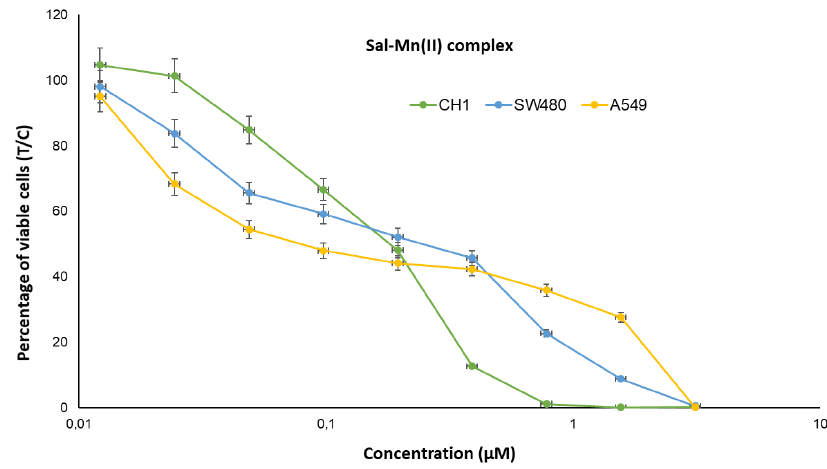
Figure 6. Concentration-effect curves of the Sal-Mn(II) complex in A549 (yellow), CH1/PA-1 (green), and SW480 (blue) cells, determined by the MTT assay after 96 h treatment. Values are normalized relative to untreated controls and represent means and standard deviations of at least three independent experiments.